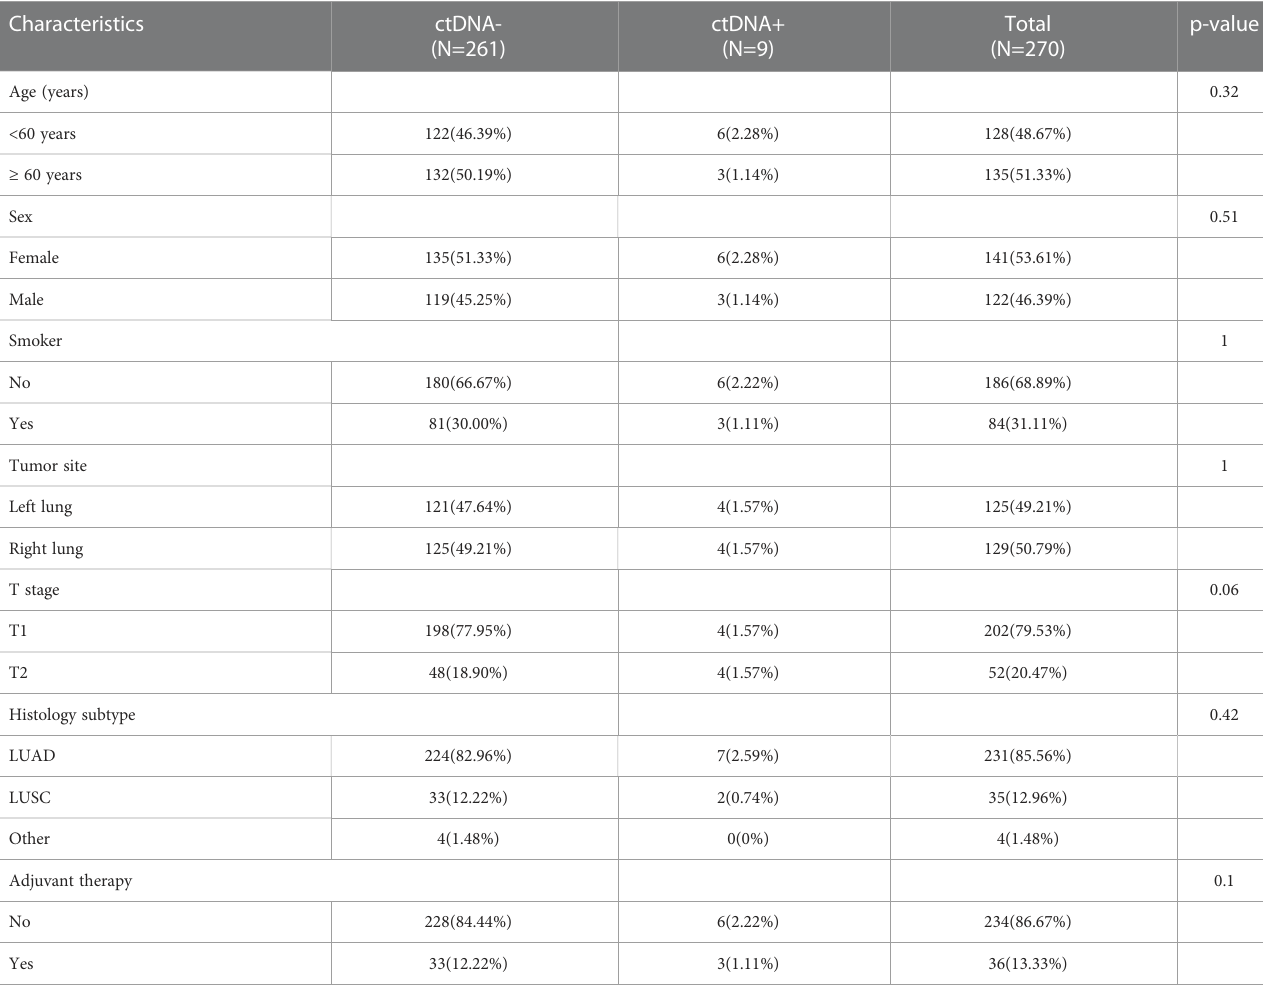
TABLE 1 The clinicopathologic characteristics of patients.